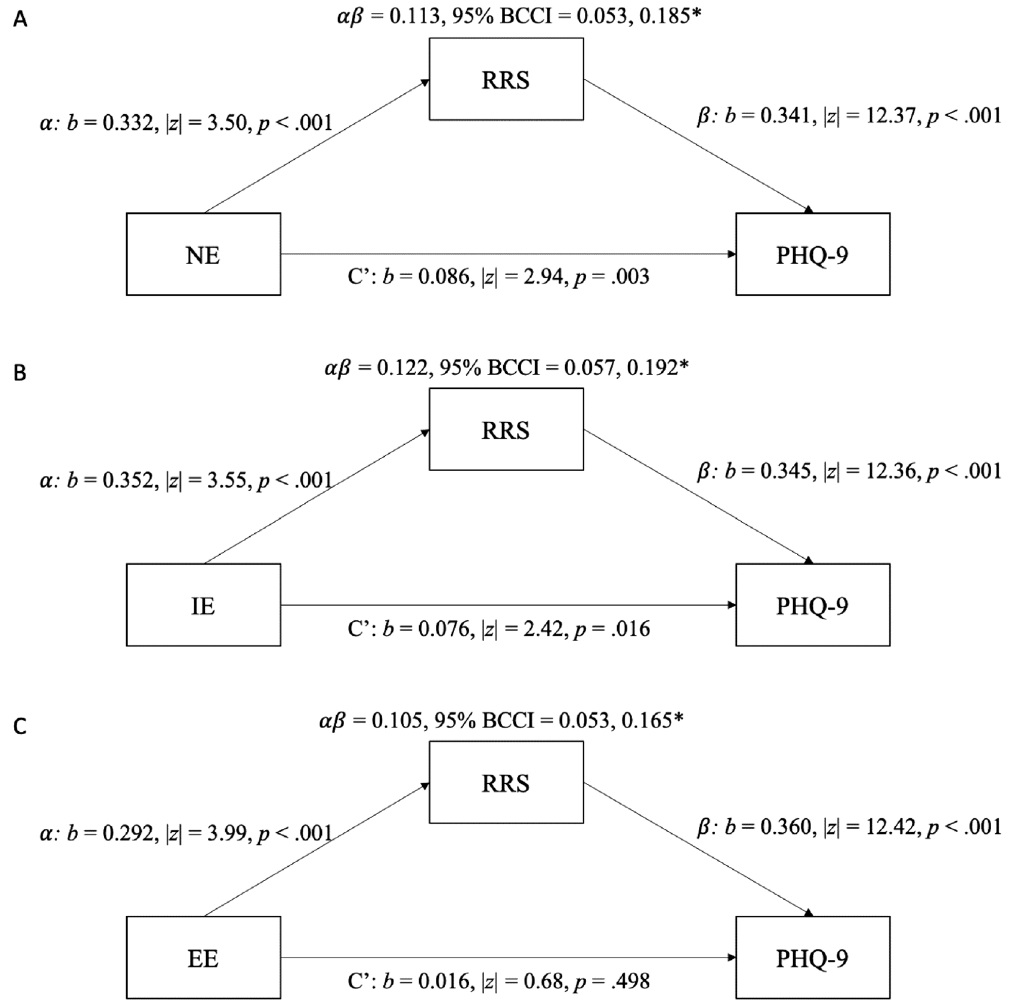
Figure 3. Analysis of indirect effects for RRS between NE inhibition ( A ), IE inhibition ( B ) and EE inhibition ( C ) and depression (PHQ-9 total